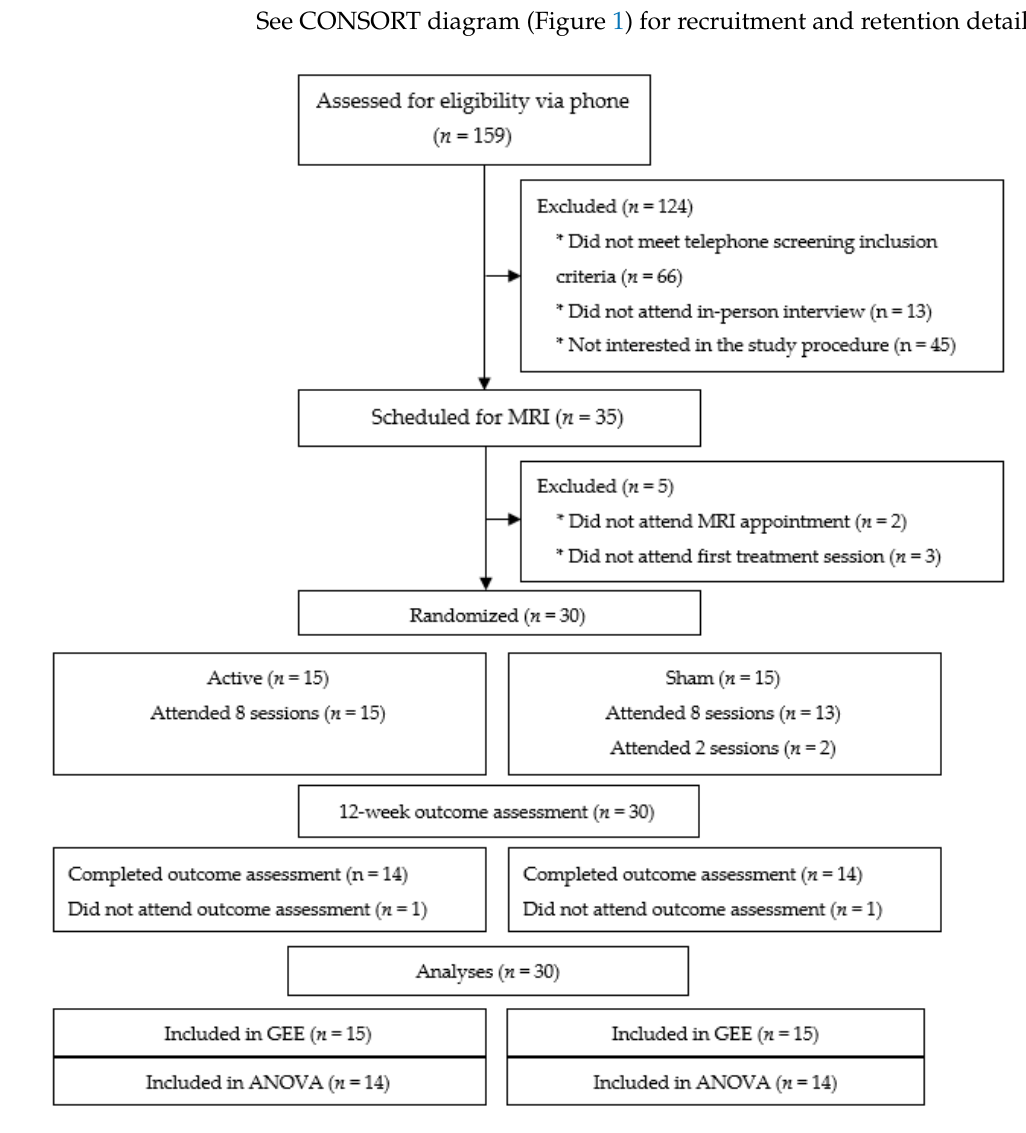
Figure 1. CONSORT diagram.